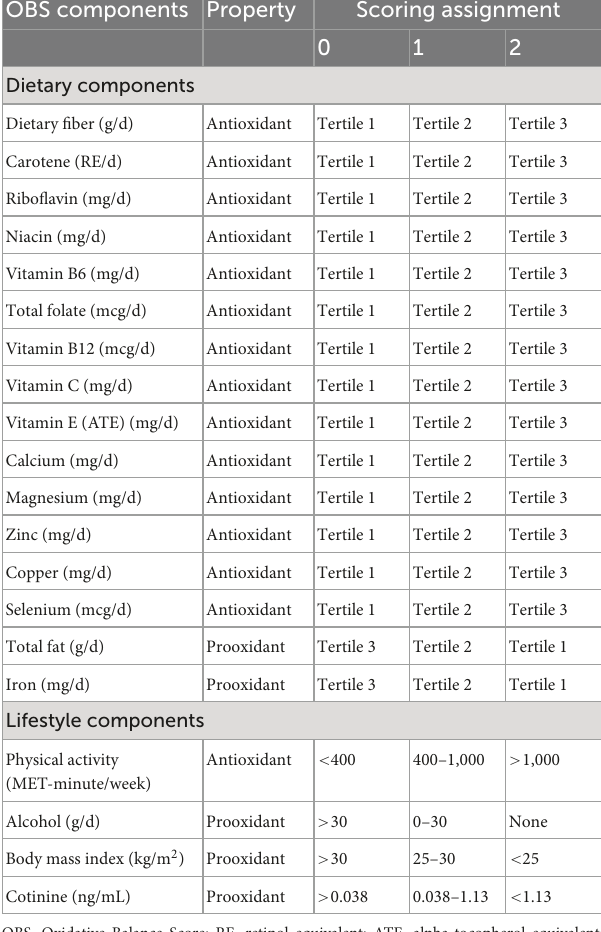
TABLE 1 Oxidative Balance Score assignment